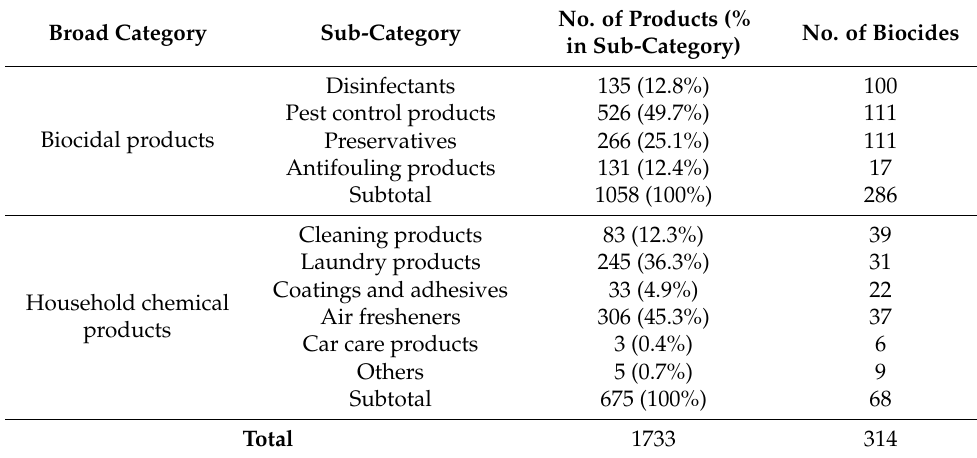
Table 2. Prevalence of the biocides in biocidal and household chemical products that had two or more